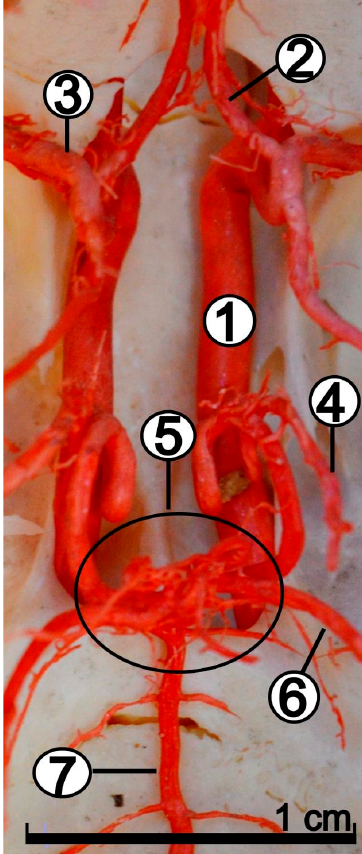
Figure 4. Dorsal view of the arterial circle of the brain. Vessels in the cranial cavity on the skeletal scaffold. Corrosion cast. 1—internal carotid artery; 2—rostral cerebral artery; 3—middle cerebral artery; 4—caudal cerebral artery; 5—caudal communicating artery; 6—rostral cerebellar artery; 7— basilar artery. Animals 2022 , 12 , x FOR PEER REVIEW In the vicinity of the origin of the caudal communicating arteries, the internal carotid artery gives way to the caudal cerebral artery ( arteria cerebri caudalis ) (Figure 5).